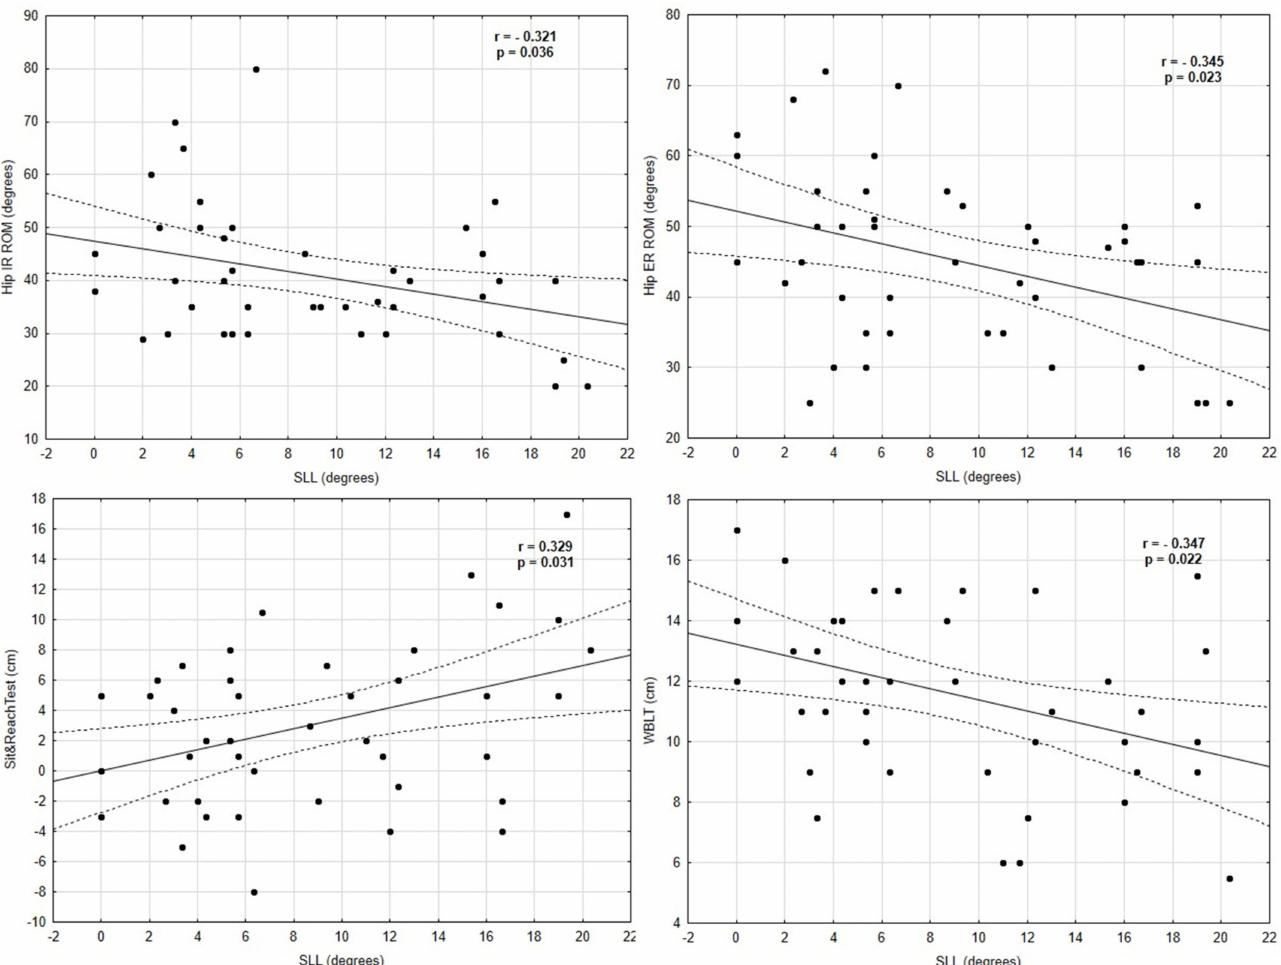
Figure 3. Correlations between the SLL and the hip ER ROM, hip IR ROM, sit and reach test, and WBLT